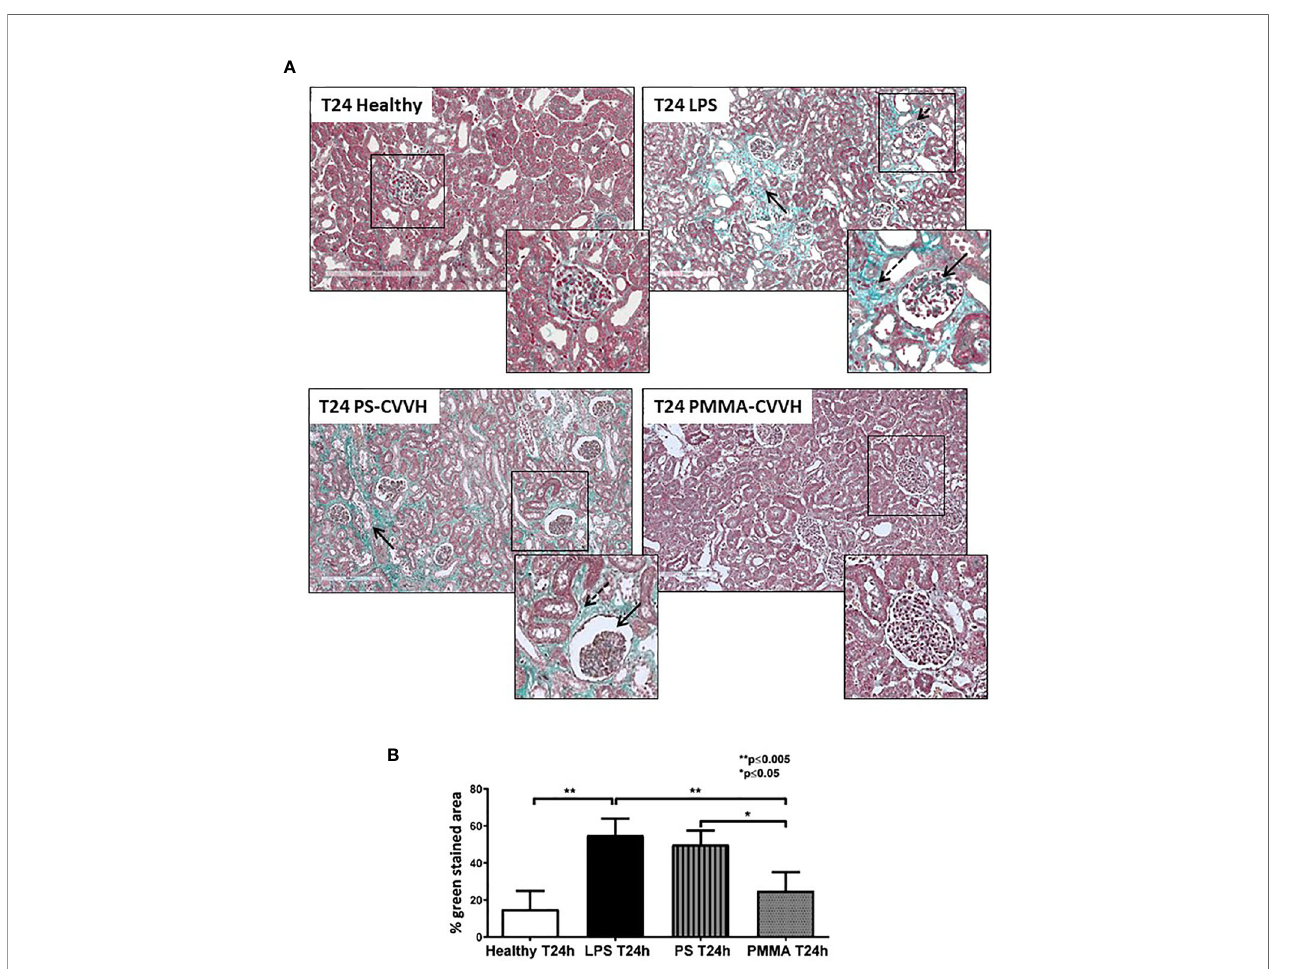
FIGURE 3 | PMMA-CVVH treatment prevented early fi brosis in endotoxemic pigs. Masson trichrome staining (A) revealed extensive collagen deposition at the interstitial level, along capillaries (zoomed image, black arrow), and diffuse glomerular thrombi (zoomed image, dotted black arrow) in endotoxemic pigs compared with T24 of the control group (T24 Healthy). Renal biopsies after PS-CVVH treatment did not reduce collagen deposits (black arrows). Otherwise, PMMA-CVVH treatment strongly decreased collagen deposits (zoomed image, black arrows) and renal damage. (B) The quantitative analysis was obtained as described in the Methods section and expressed as median ± IQR of at least fi ve pigs for each group (Healthy and PMMA T24 group, n = 7, LPS T24 n = 5, PS T24 n = 6). Statistically signi fi cant differences were assessed by the Mann – Whitney test (*p < 0.05; **p <